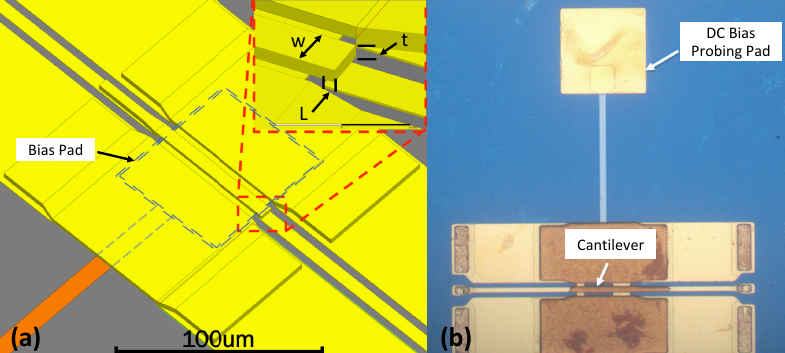
Figure 1. ( a ) 3-D model of an electro-static actuated MEMS switch in a series configuration. The switch’s OFF state isolation is provided an air gap between the actuator’s tip and the CPW section’s tip. When applying external DC bias, the electrostatic force between the bias pad and the actuator will pull the actuator down and provide an RF signal path. ( b ) A photomicrograph of a fabricated switch.